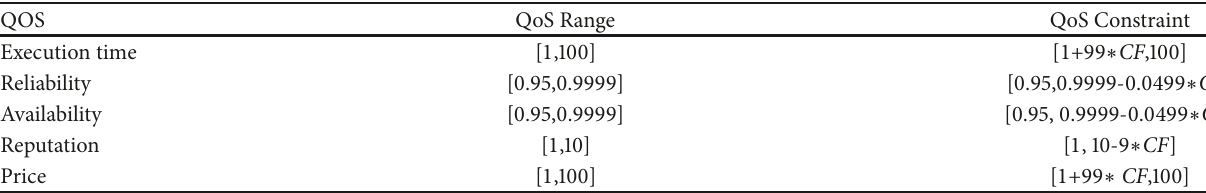
Table 1: Values of five